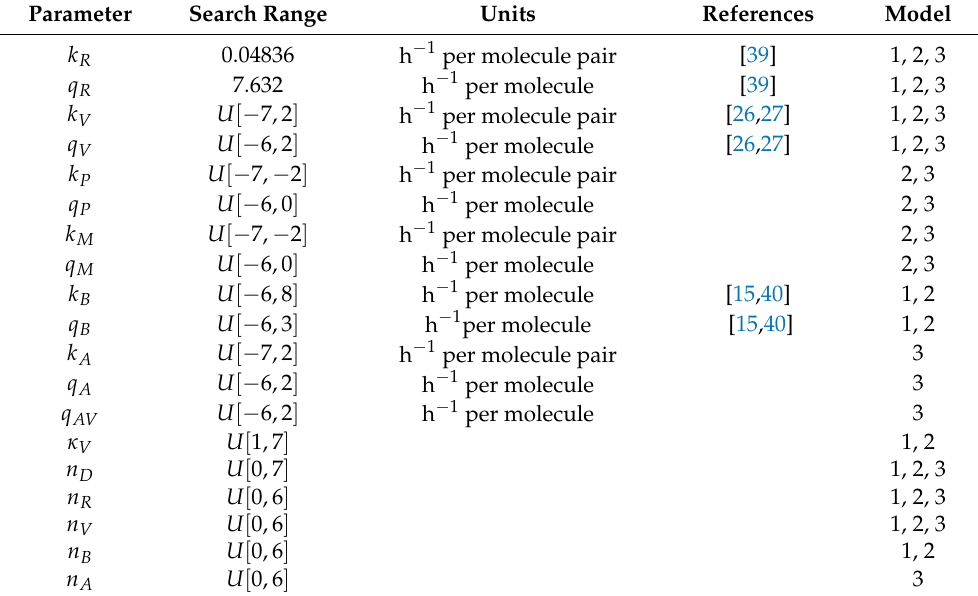
Table 2. Parameter ranges used for Bayesian inference. Ranges were taken based on the published and data, with two to three orders of magnitude taken on either side of these values [11,15,26,27,39]. We consider uniform distributions of exponent base 10 for all prior choices. We then restrict parameters k V and q V by making sure their ratio, k V , lies within the dissociation constant range 3.40 µ M–1.1 nM q V reported in Refs.